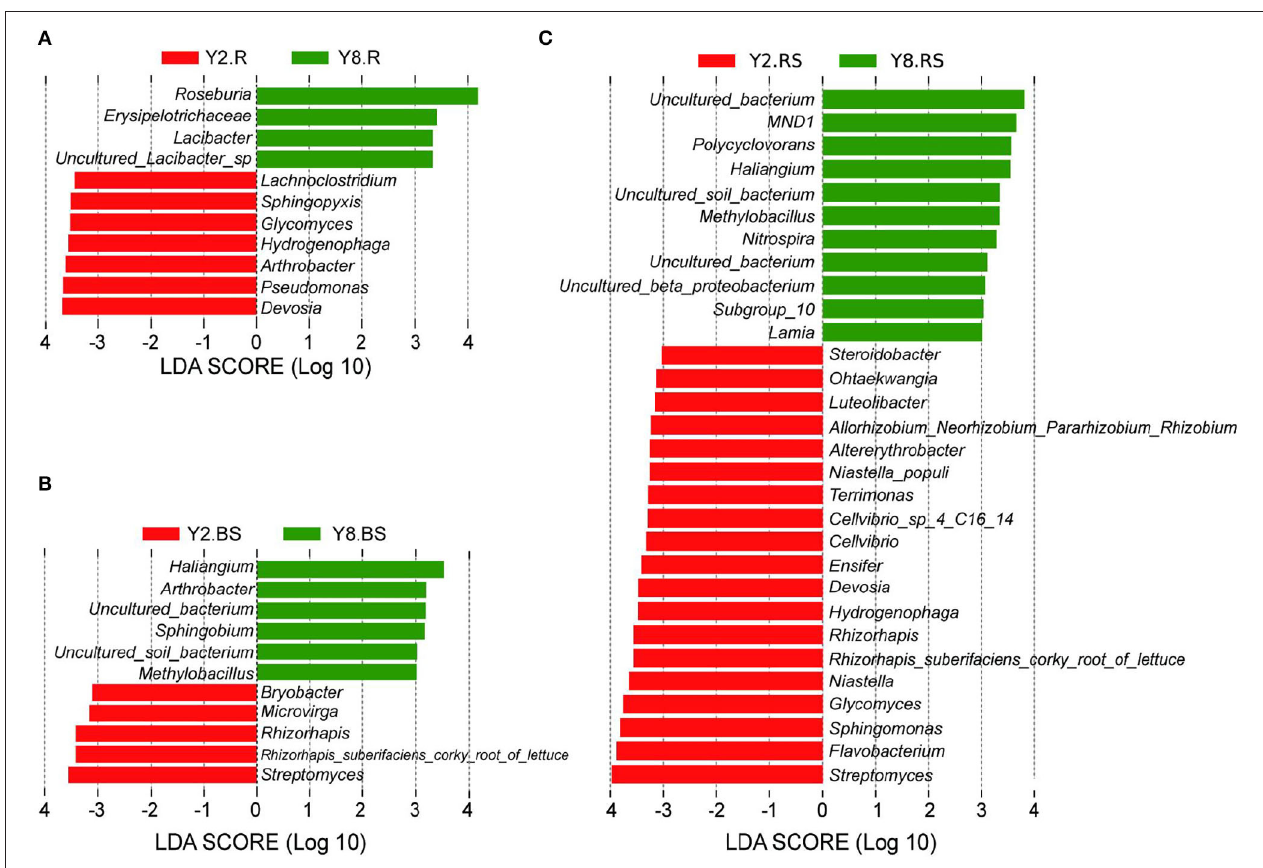
FIGURE 5 | The enrichment analysis of bacterial taxa in all the groups at the genus level [linear discriminant analysis (LDA) > 3]. (A) Linear discriminant analysis effect size (LEfSe) analysis with significant differences based on Y2.R and Y8.R. (B) LEfSe analysis with significant differences based on Y2.BS and Y8.BS. (C) LEfSe analysis with significant differences based on Y2.RS and Y8.BS. Abbreviations: Y2.R, root of 2 years of continuous cropping; Y8.R, root of 8 years of continuous cropping; Y2.RS, rhizosphere soil of 2 years of continuous cropping; Y8.RS, rhizosphere soil of 8 years of continuous cropping; Y2.BS, bulk soil of 2 years of continuous cropping; Y8.BS, bulk soil of 8 years of continuous